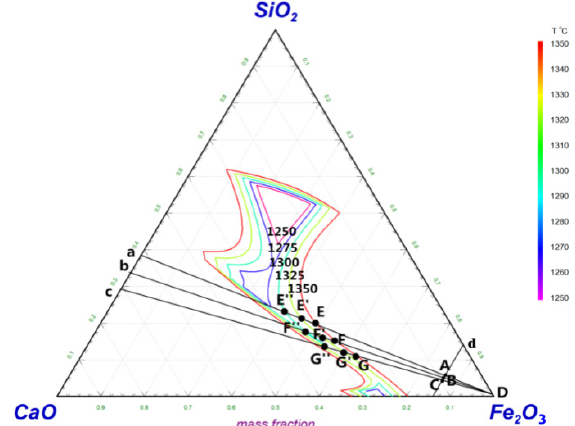
Figure 1. Liquid region of the CaO ‐ SiO 2 ‐ Fe 2 O 3 ‐ Fe 3 O 4 ‐ Al 2 O 3 ‐ MgO